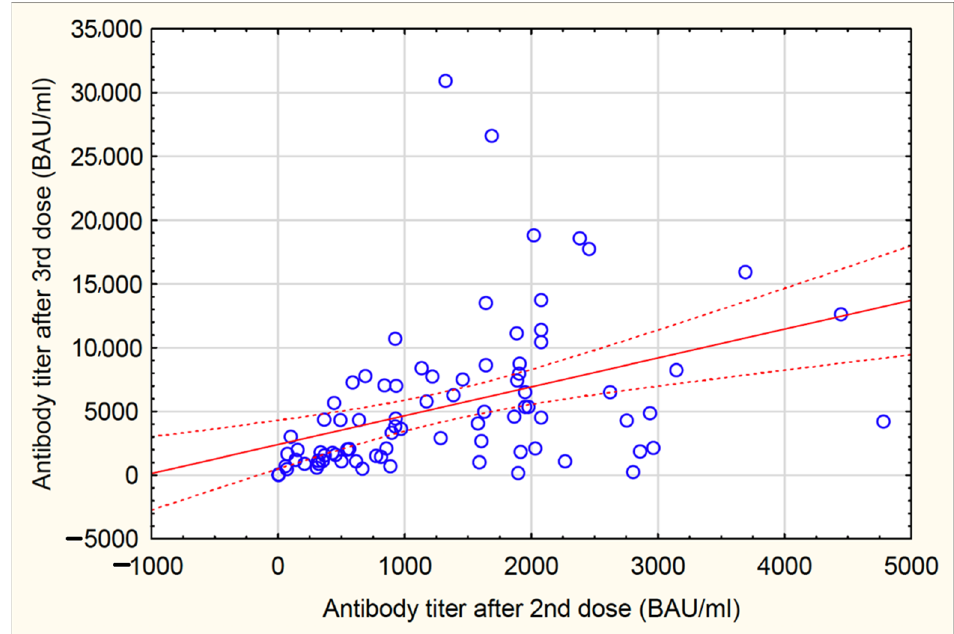
Figure 3. Association between anti-S antibody titer after second and third dose in IN-D patients.